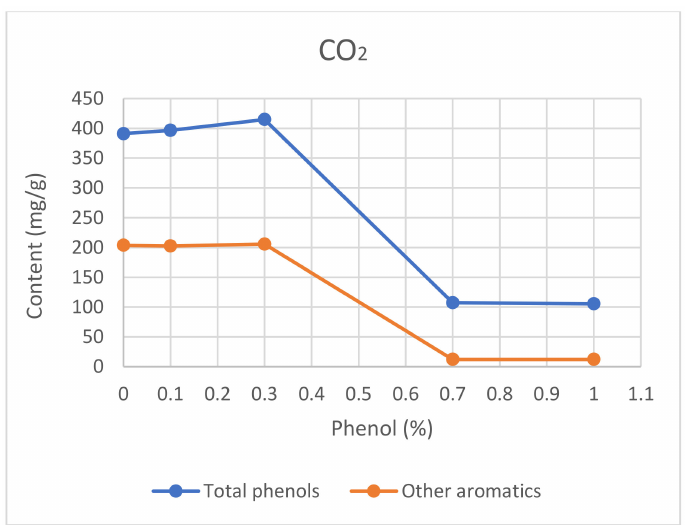
Figure 6. The influence of the phenol concentration on the formation of monomeric depolymerization products of lignin in a carbon dioxide